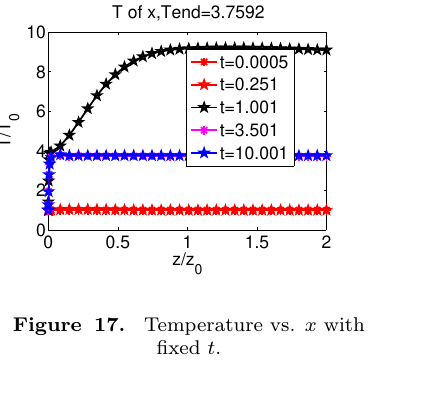
Figure 18. CO concentration vs. x with fixed t